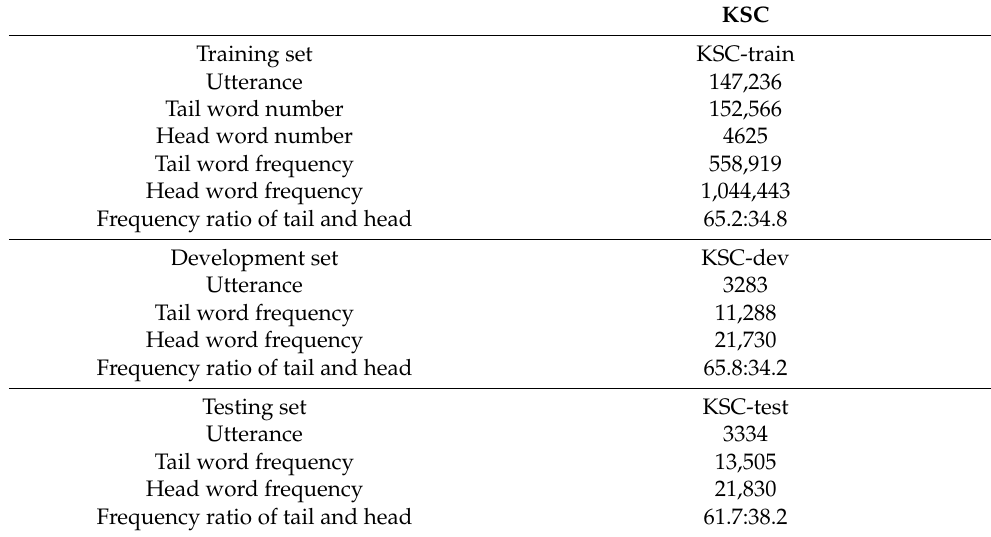
Table 1. Like [46]-style long-tail data distribution in the Kazakh language